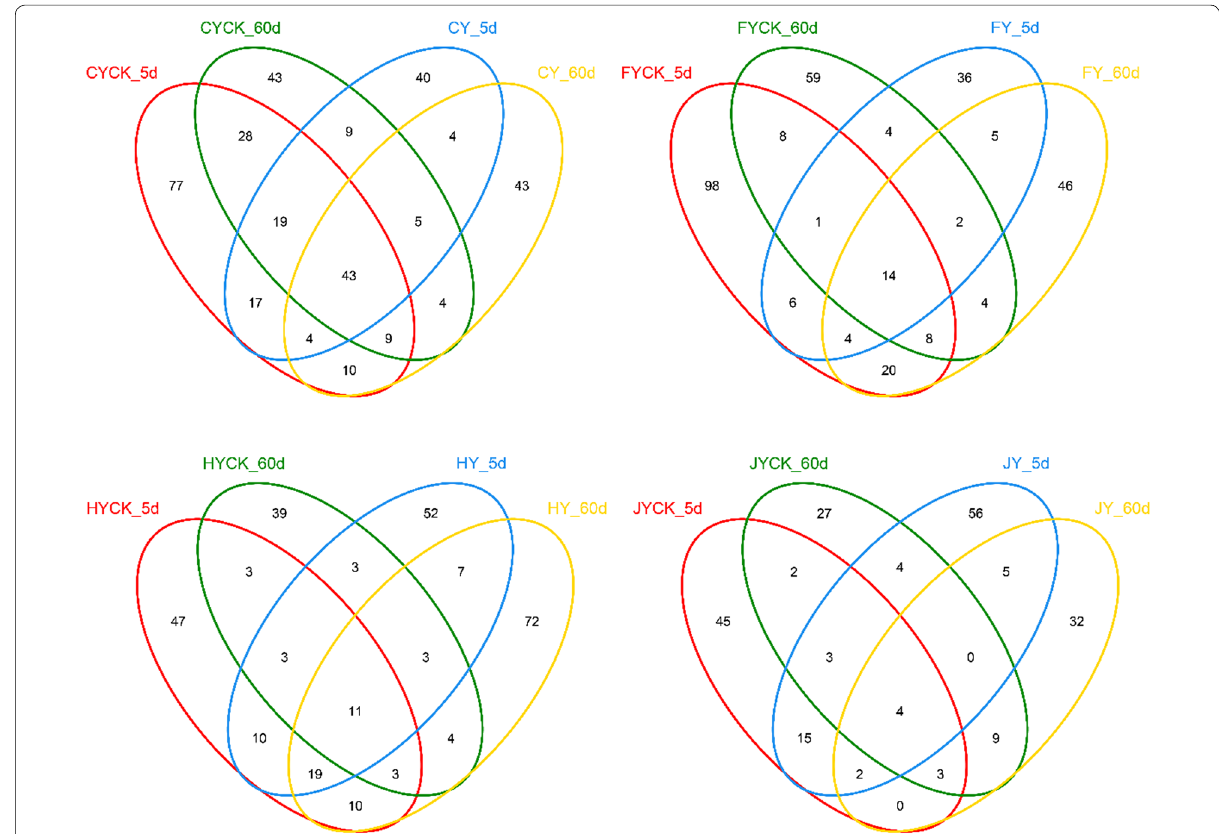
Fig. 4 Fungal Venn analysis in soils